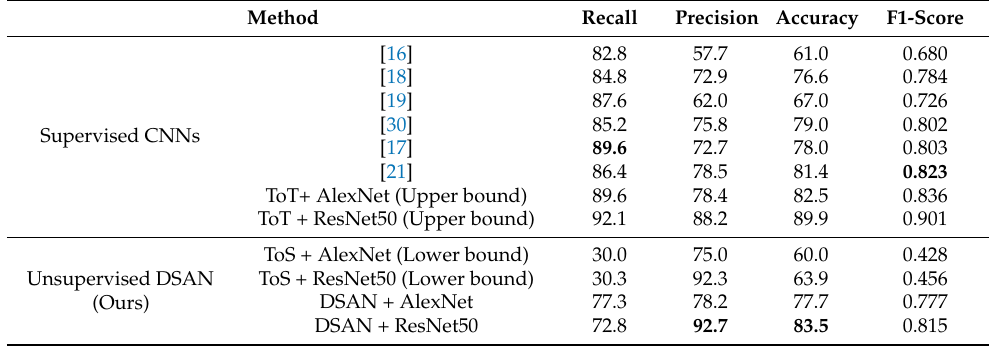
Table 6. Quantitative results of supervised CNNs and DSAN on the challenging testing set of